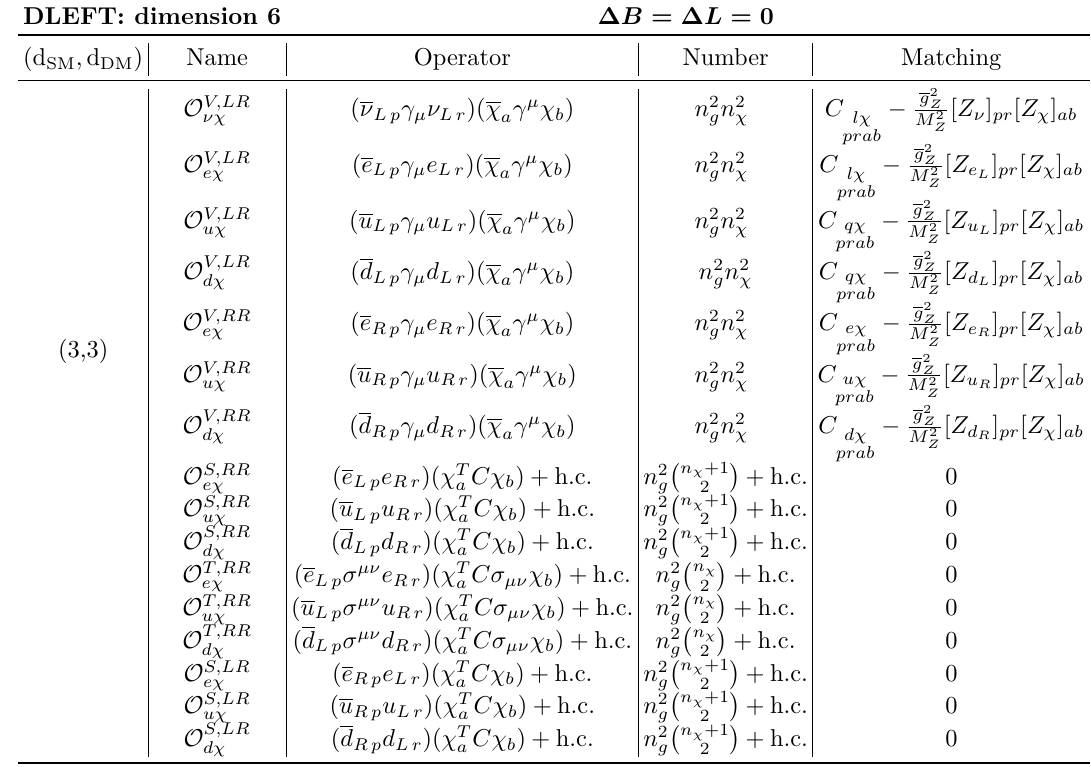
Table 22 . Dimension-six ∆ B = ∆ L = 0 operators in DLEFT, part 3. The first column gives the dimensions of the SM and DM part of the operator, the fourth column is the number of operators, and the fifth column is the additional matching contribution at the EW scale.